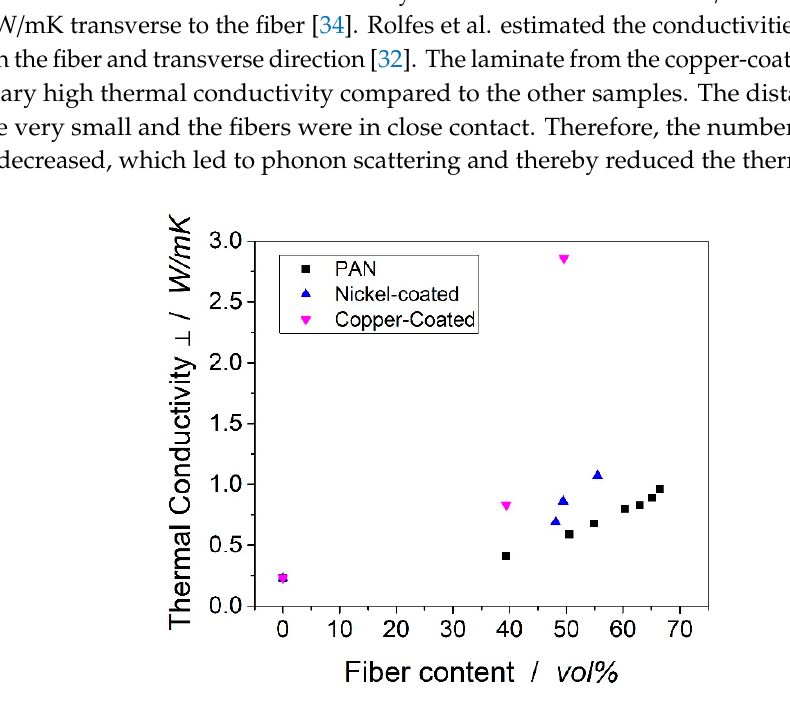
Figure 7. Transverse thermal conductivity of laminates vs. fiber volume content. The standard deviation is not visible in the graphs.